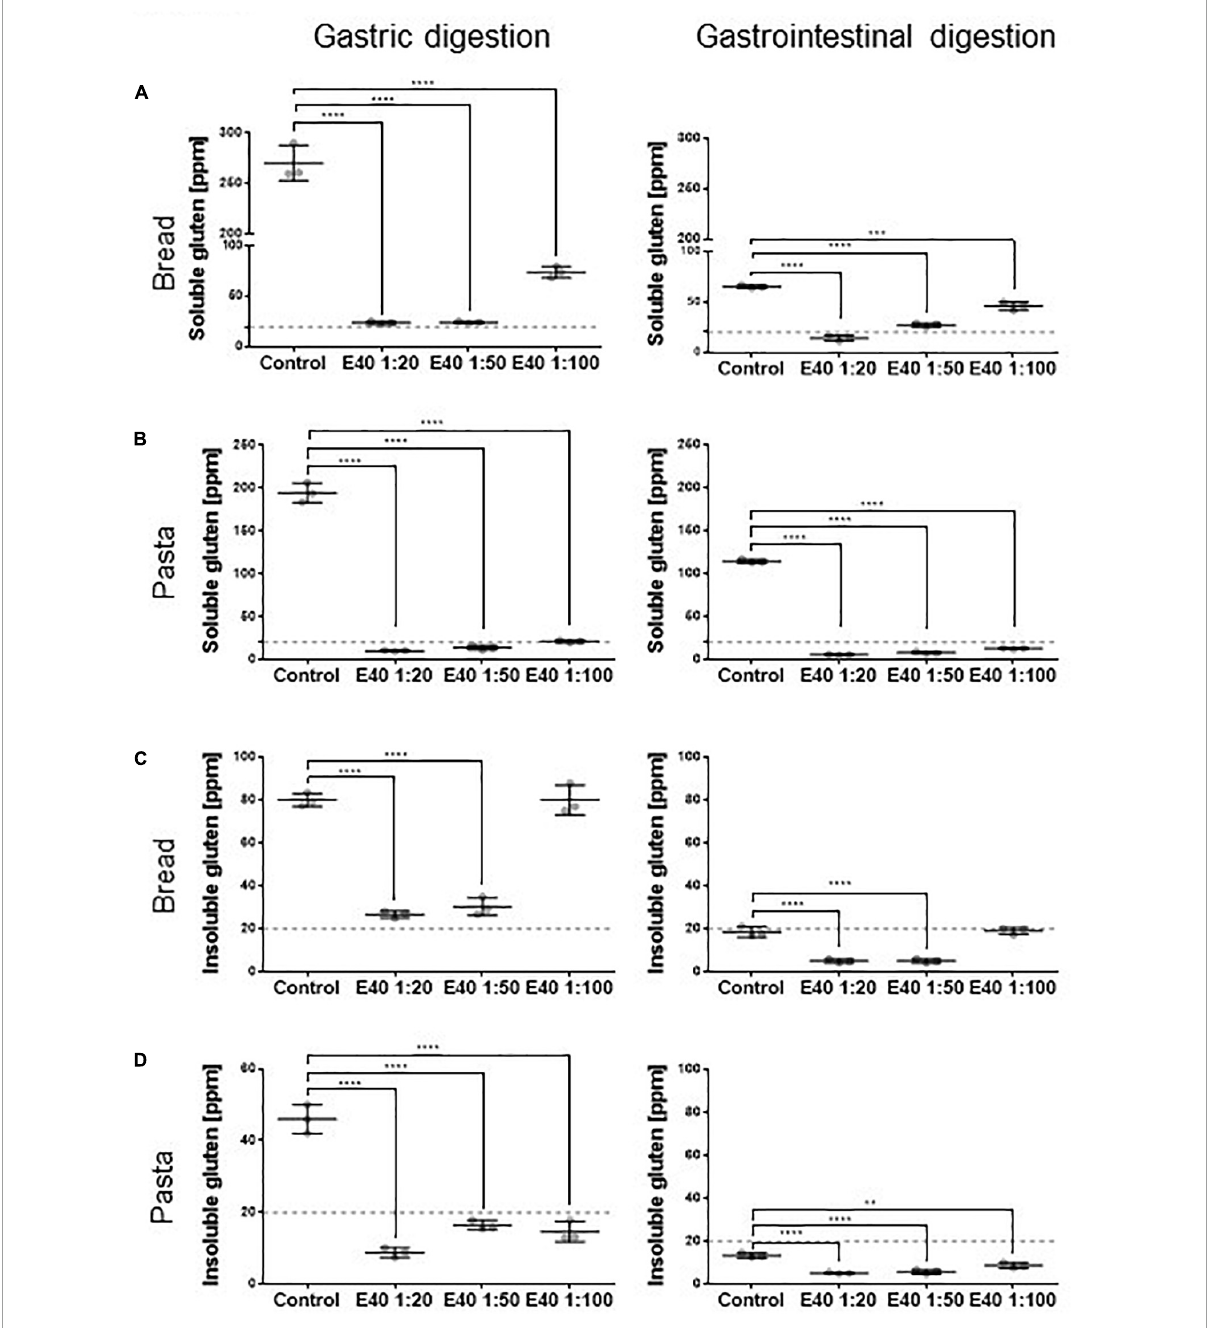
FIGURE2 Residual soluble and insoluble gluten content in bread (A,C) and pasta (B,D) samples. (A,B) Residual gluten content in its soluble form as assessed by competitive R5 ELISA. (C,D) Residual gluten content in its insoluble form as assessed by sandwich R5 ELISA. Dotted line: 20 ppm, the threshold for gluten-free food. Data are shown as mean ± SD of n = 3 repetitions. Data were analyzed by one-way ANOVA followed by Dunnett’s multiple comparisons test, *: 0.01 < p < 0.05; **: 0.001 < p < 0.01; ***: 0.0001 < p < 0.001; ****: p < 0.0001.